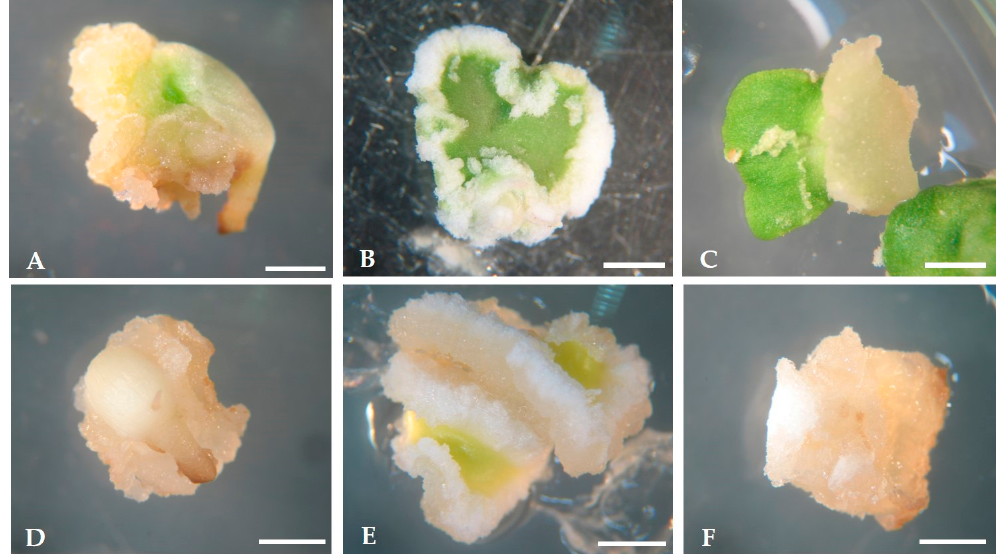
Figure 2. Calli formation in the two light regimes, 16 h photoperiod ( A – C ) and darkness ( D – F ), for the three types of initial explants, radicles ( A , D ), proximal cotyledon region ( B , E ) and distal cotyledon region ( C , F ). Bars: 10 mm.